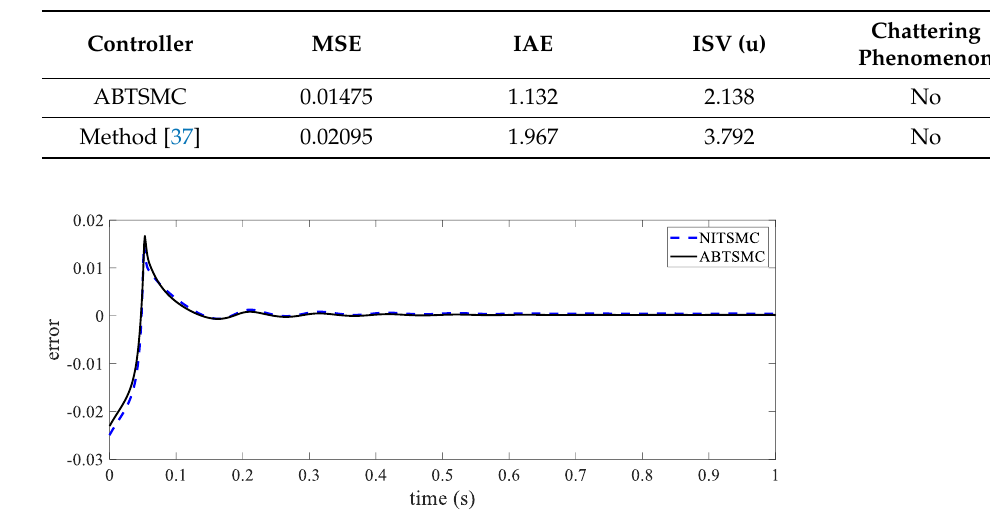
Figure 9. Comparison between ABTSMC and NITSMC error signals.